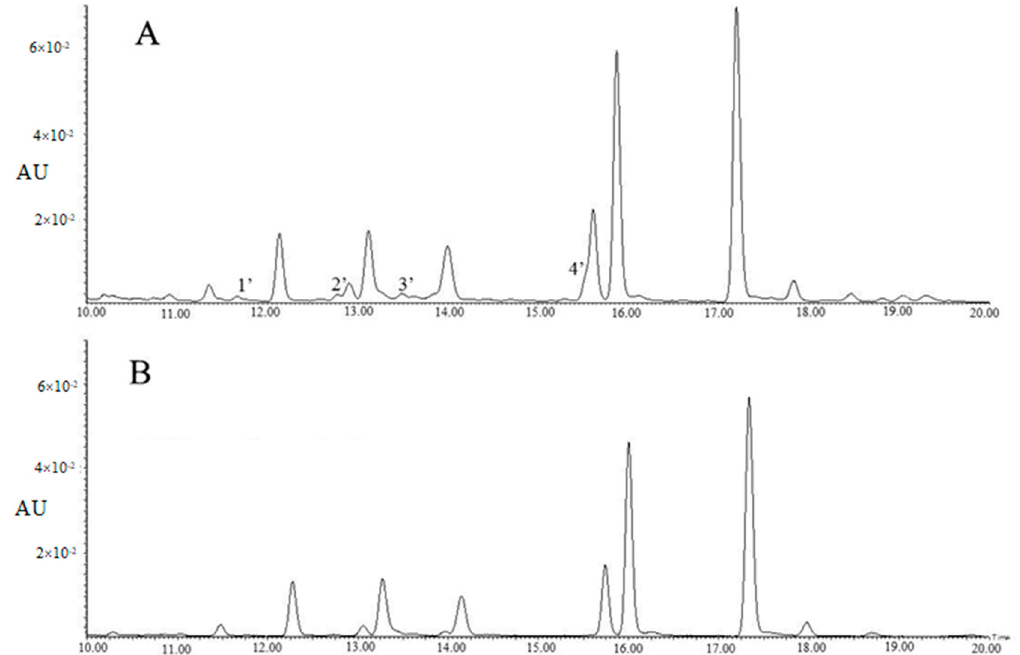
Figure 2. The UPLC chromatograms of 60% methanol fraction ( A ) and 45% methanol fraction ( B ) ( λ = 280 nm). Peak 1 (cid:48) : 4’-glucosylvitexin; Peak 2 (cid:48) : unknown compound; Peak 3 (cid:48) : rhamnosylvitexin; Peak 4 (cid:48) : unknown compound. Table 3. The e ff ect of flow rate on the chemical compositions of 45% methanol fractions ( µ g / mL).